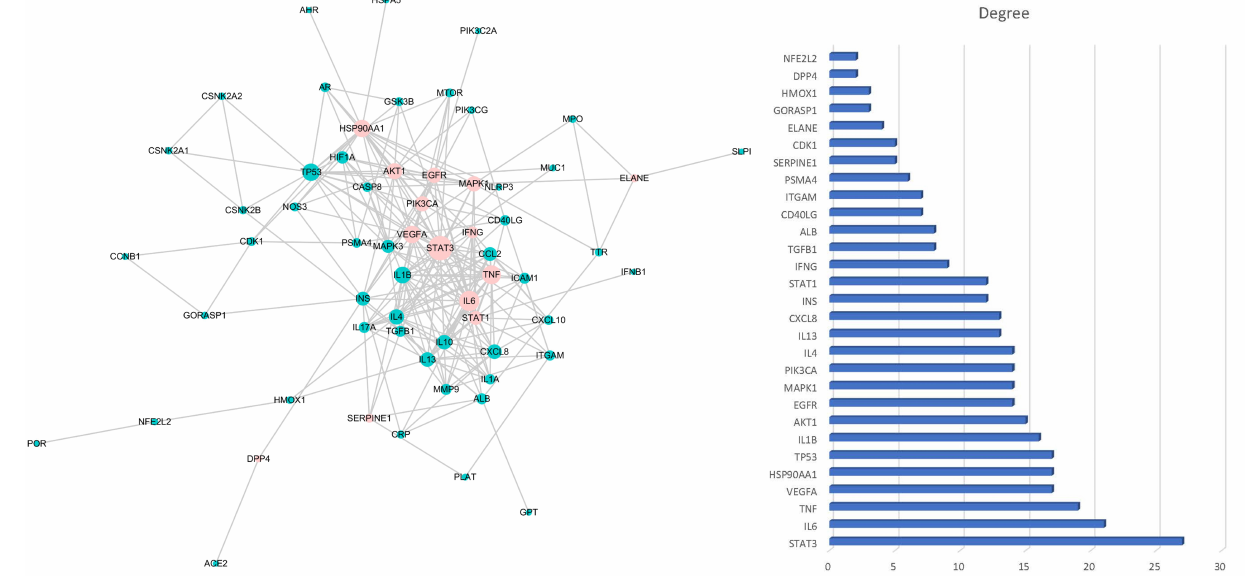
Figure 3. Protein–Protein Interaction network (PPI) of common targets. The size of nodes in the left picture represents the degree of targets. The picture on the right-hand side is the key protein in the PPI network and correlated degree. The y-axis is the gene symbol of the key targets, and the x-axis is the degree of the